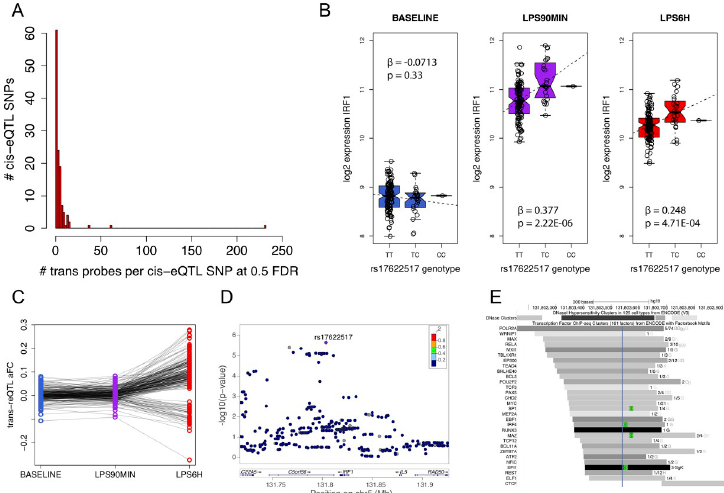
Fig 1. eQTL analysis. A) Histogram showing the number of trans-eGenes at 0.5 FDR per each tested cis-eQTL locus with 6h LPS stimulation. The rightmost bar is the IRF1 locus; B) the rs17622517 cis-eQTL for IRF1, and C) and its trans-eQTL effect sizes (allelic fold change) under the three conditions; D) the association landscape for the IRF1 cis- eQTL signal; E) overlap of rs17622517 (blue line) with ENCODE transcription factor ChIP-seq peaks (grey) and motifs (green). Intensity of grey scale is proportional to the intensity of the ChIP-seq